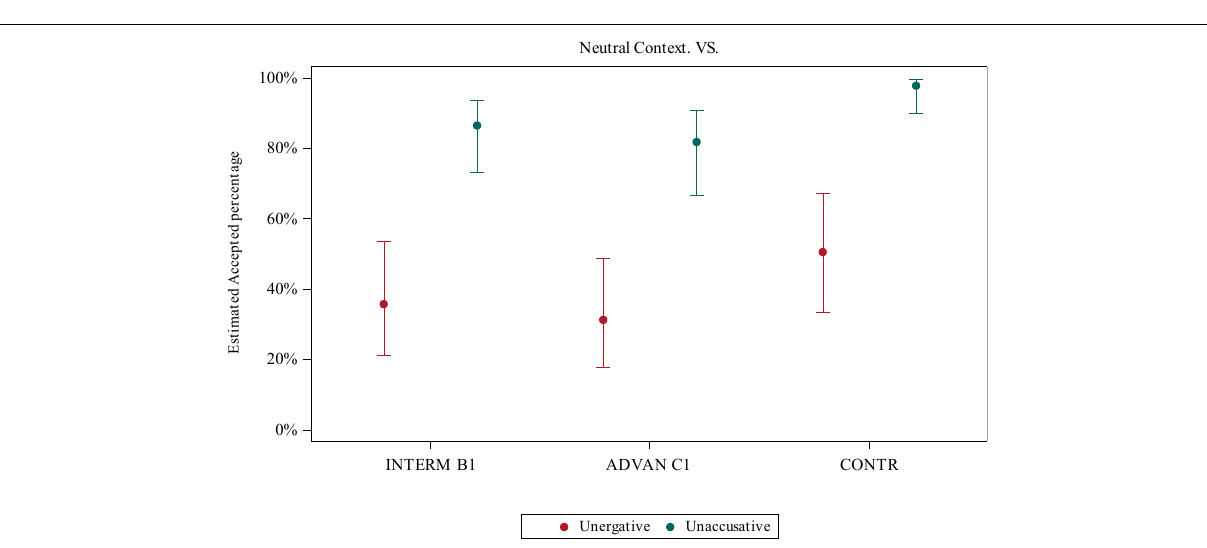
FIGURE 3 | Estimated acceptance percentage for the VS condition in neutral contexts according to Verb